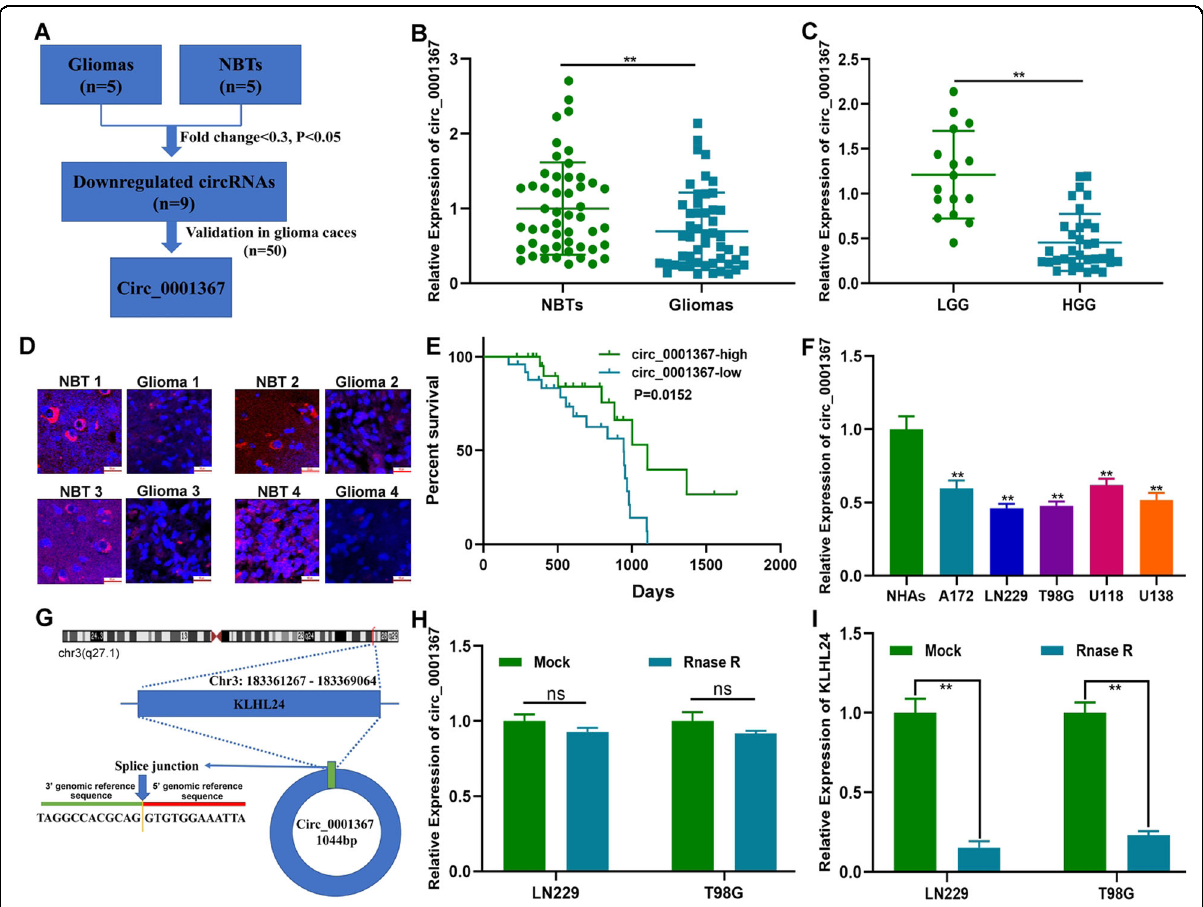
Fig. 1 Circ_0001367 was downregulated in glioma and associated with a poor prognosis. A Schematic illustration of the identi fi cation of circRNAs downregulated in glioma tissues compared with adjacent NBTs. B The expression of circ_0001367 was detected using qRT-PCR in glioma surgical specimens and paired adjacent NBTs. C Expression of circ_0001367 in surgical specimens of low-grade glioma (LGG) and high-grade glioma (HGG). D The expression of circ_0001367 was detected using FISH in glioma specimens and paired adjacent NBTs. (Red: circ_0001367, Blue: DAPI). E Kaplan – Meier analysis of glioma patients with high or low expression of circ_0001367. F qRT-PCR was performed to verify circ_0001367 expression in glioma cell lines. G Schematic illustrations showing the genomic loci of circ_0001367. H , I RNase R treatment indicated that circ_0001367 RNA was resistant to RNase R in LN229 and T98G cells. Each experiment was performed in triplicate. Data are expressed as mean ± SD, ** P <